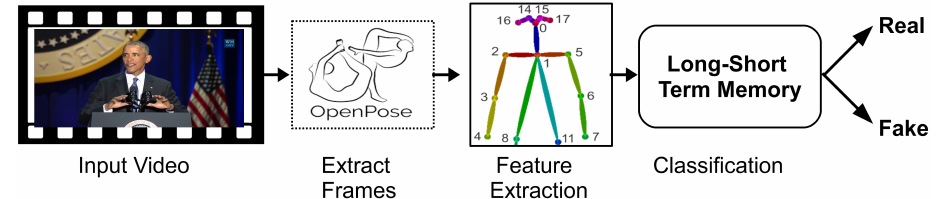
Figure 1. Deepfake detection: In this deepfake detection process, the video frames are extracted, and a machine learning algorithm is trained on them. Later, the inference system classifies the given video as a deepfake or